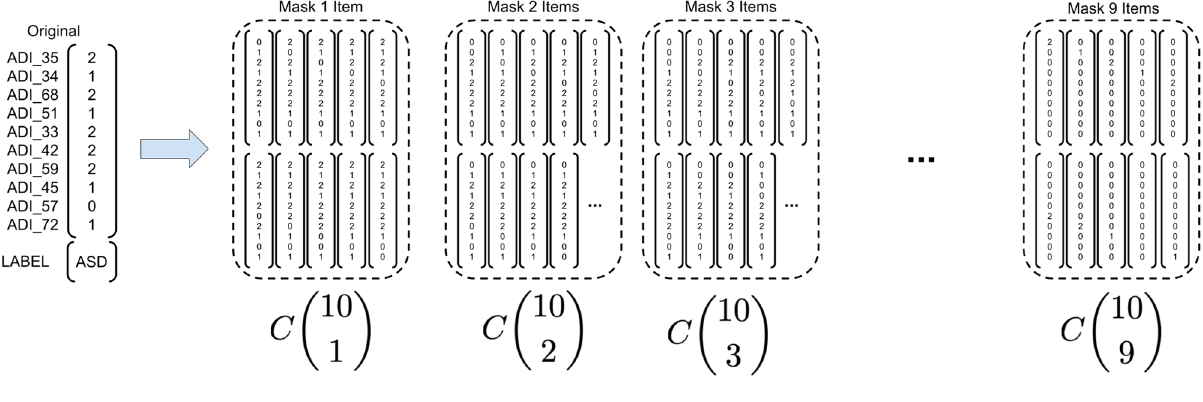
m n (cid:30) ( m (cid:31)